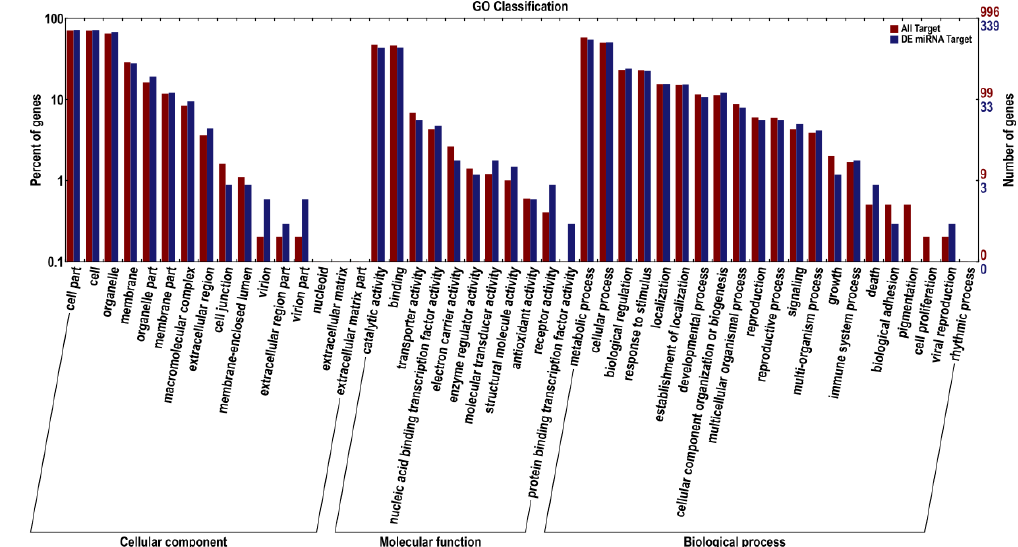
Figure 4. Gene Ontology (GO) annotated cluster map of putative target genes of differentially expressed miRNAs in A. Mongolicum , classified in three main categories (cellular component, molecular function, and biological process.